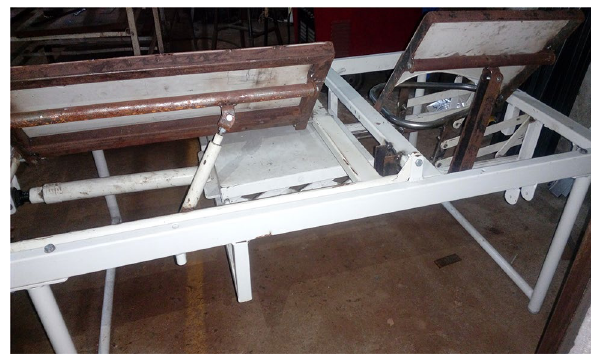
Fig. 9 Photo of bed in raised side